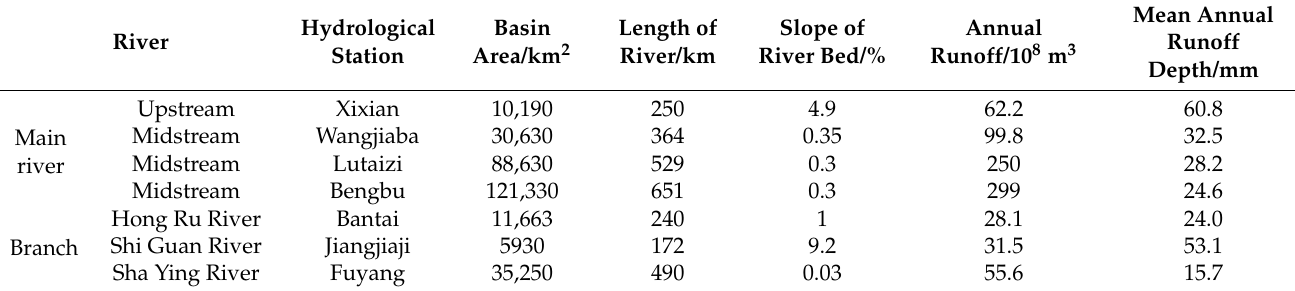
Table 1. Locations of the hydrological stations considered in this study and related geographical features.